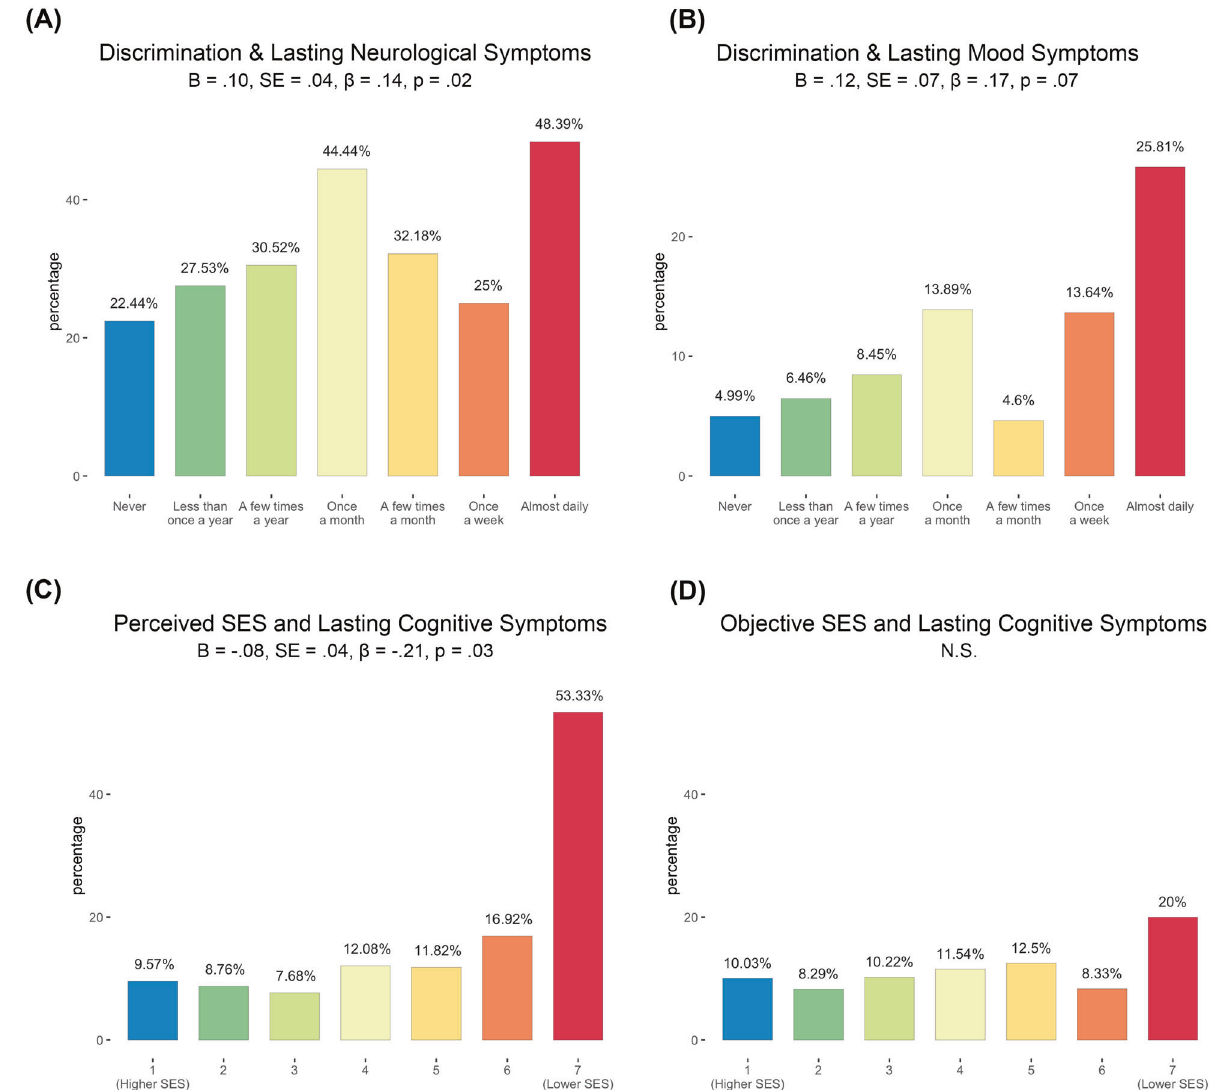
Fig. 4 Perceived discrimination and perceived SES predict increased neurological and cognitive symptoms after recovery from COVID-19. Post hoc logistic regressions provide evidence that individuals reporting greater discrimination frequency had a signi fi cantly greater likelihood of reporting lasting neurological symptoms, p = .02 ( A ). Further, data demonstrate that perceived ( C ) but not objective ( D ) SES predicts lasting cognitive complaints after recovery from COVID-19 illness. There was a trend in the relationship between increased discrimination frequency and lasting mood symptoms, p = .07 ( B ). All analyses controlled for non-white race, cumulative SES risk score, perceived SES score, history of diabetes/heart disease, COVID-illness life disruption, COVID-illness anxiety, and early versus late illness onset (i.e., peak 1 versus peak 2).